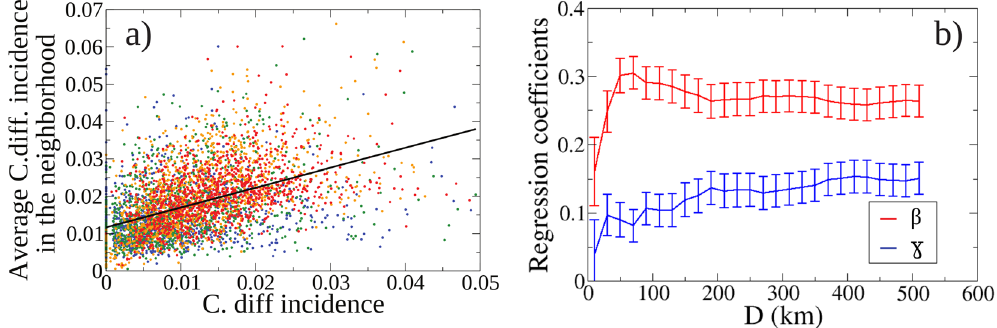
Figure 2. C. difficile incidence in a general facility and its neighbors. ( a ) Here we plot the C. difficile incidence of every general facility with less than 0.05 incidence on the x-axis and the average C. difficile incidence of the neighboring facility in the transfer network, where a neighboring facility is one that either sends it patients to or receives its patients from the case facility. Facility size in beds is represented by color: the first (lowest) quartile (in size) of facilities shown is plotted in blue, the second in green, third in orange and the fourth (largest) quartile in red. 74 hospitals (1.6% of sample) with C. difficile incidence greater than 0.05 were excluded from the plotting area. ( b ) Logistic regression coefficients as a function of distance. Coefficient for the average incidence in network neighbors (red) and not linked through transfers (blue) up to a distance D . Error bars show the 95% CI. This result can be interpreted in terms of z-scores: at a distance of 100 km, an increase of one standard deviation in the average C. difficile incidence in hospitals connected through the transfer network was associated with an average increase of 33.6% in the odds of a patient being diagnosed C. difficile , while for non- connected hospitals the increase was only of